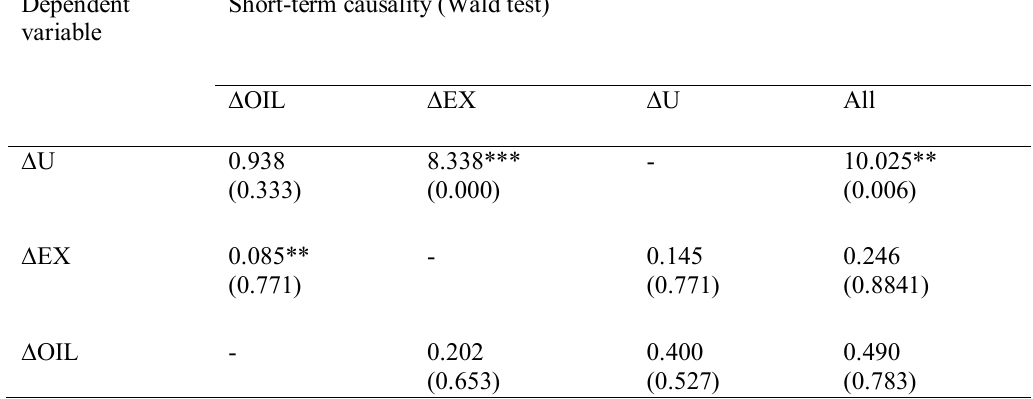
Table 5: VEC Granger Causality/ Block Exogeneity Wald